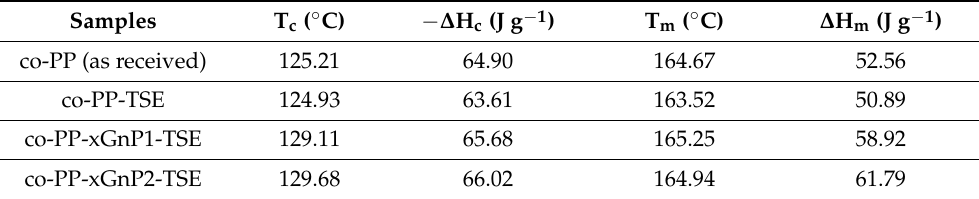
Figure 3. DSC thermograms of crystalization and melt curves of neat co-PP (as received and its composites with 1 and 2 wt % xGnP samples): ( a ) crystallization curve in first cooling cycle of samples; ( b ) crystallization time curve in the first cooling cycle of samples; ( c ) melting curves in the second heating cycle of samples. DSC: differential scanning calorimetry; co-PP: polypropylene copolymer; xGnP: graphene nanoplatelet. Table 5. Summary of the thermal parameters of neat samples and xGnP nanocomposites extracted from DSC